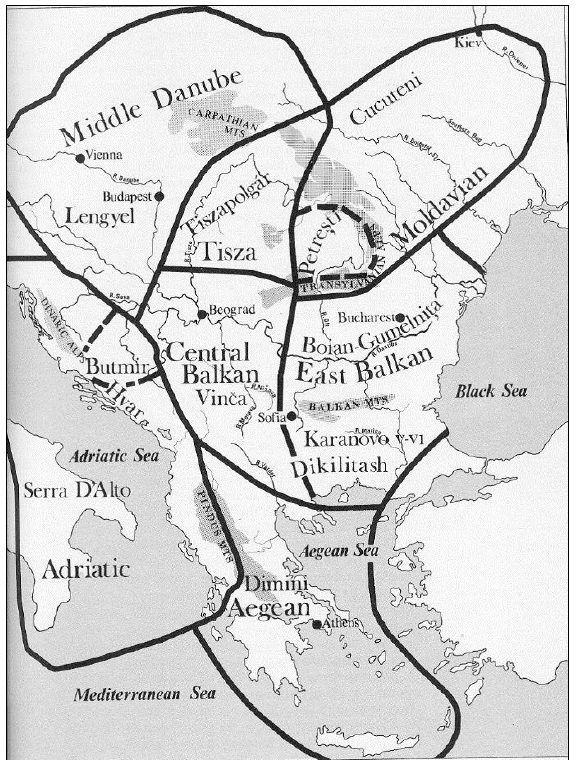
Figure 2. Map of Neolithic complexes on the Balkan Figure 1. Map of the Balkan regional groups in the Peninsula in the 7 th and 6 th millennium BC, and Map of the 5 th millennium BC [1]. Balkan regional groups in the 5 th millennium BC